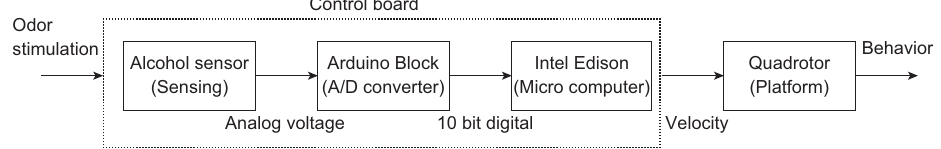
Figure 2. Series of information processing flows ranging from detecting odors to controlling the